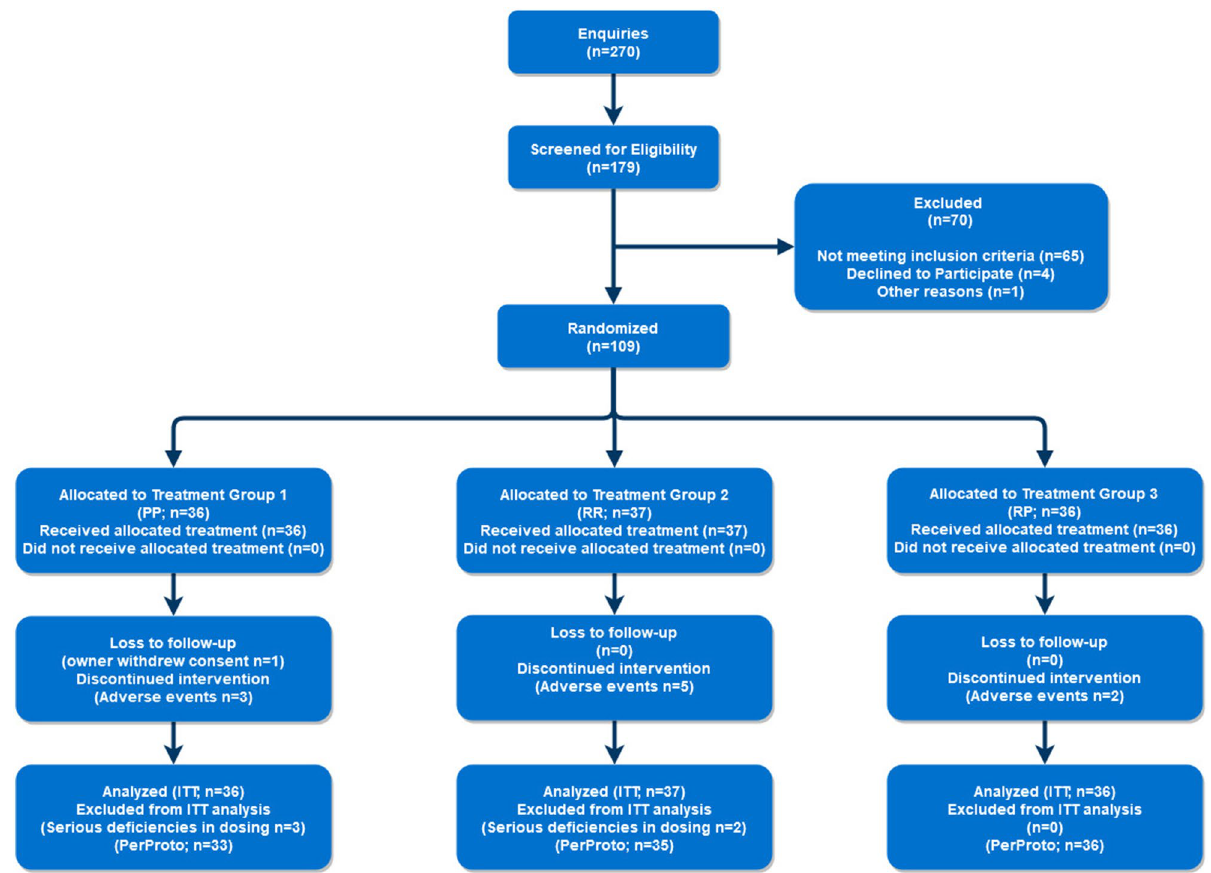
Figure 1. Patient recruitment and enrollment flowchart (CONSORT flowchart). n number of patients; treatment groups: P placebo, R robenacoxib, ITT intent to treat analysis, PerProto per protocol